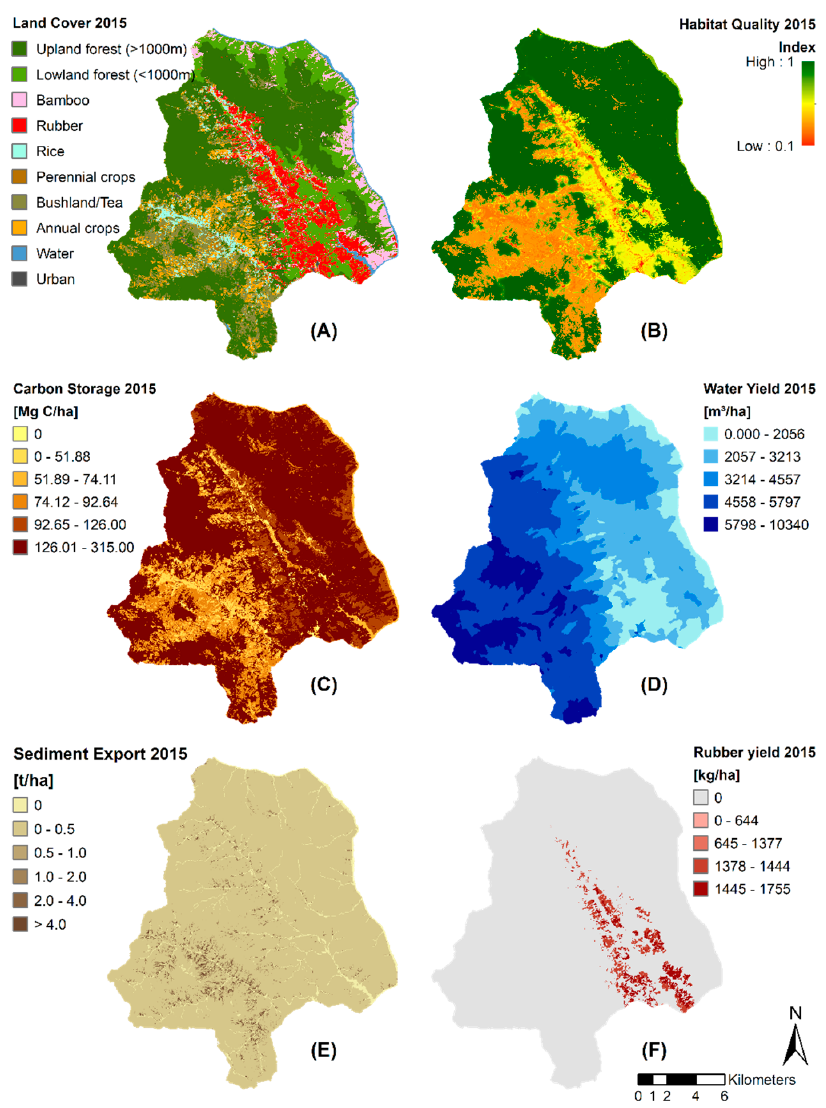
Figure 2. ( A ) depicts land cover in the Nabanhe Reserve in the baseline year 2015, derived from Rapid Eye scenes. ( B – F ) show the corresponding ESS maps for habitat quality, carbon storage, water yield, sediment export, and rubber yield, respectively. All maps feature a resolution of 30 × 30 m.